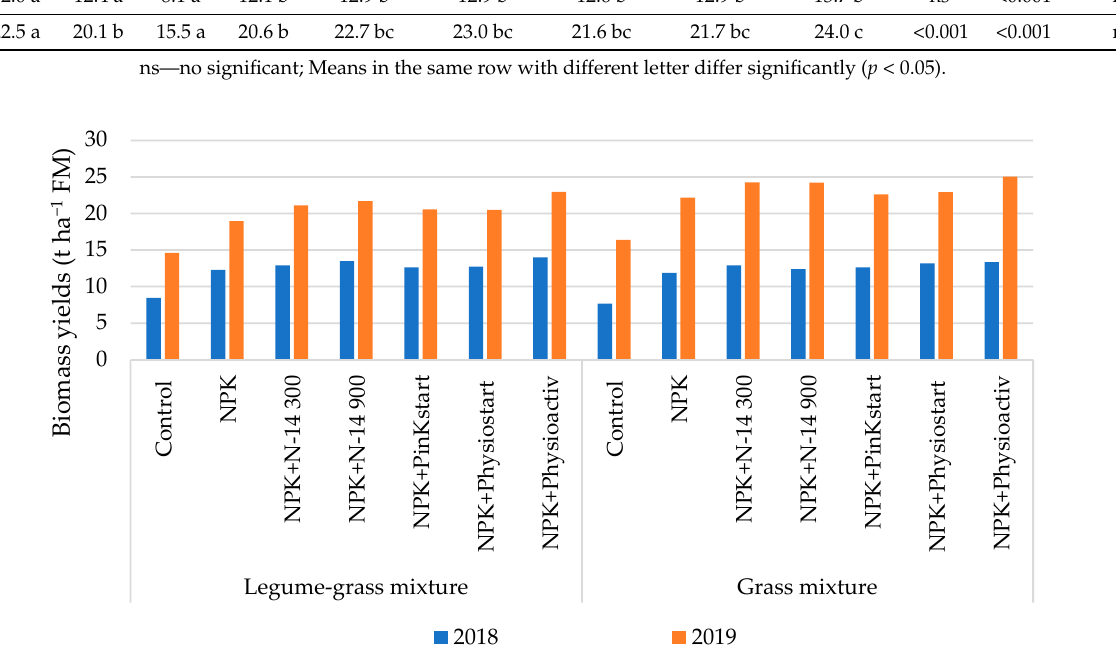
Table 3. Two-way ANOVA analyses of influence of fertilization and plant mixture on soil pH and counts of microorgan- isms in 2018–2019 (n = 168).